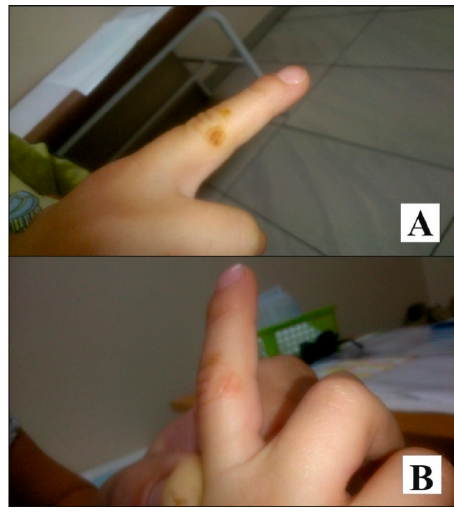
Figure 2. Viral wart on the hand following two weeks of treatment with Chelidonium majus milky sap ( A ). Viral wart on the hand following 3 weeks of treatment with Chelidonium majus milky sap ( B ).